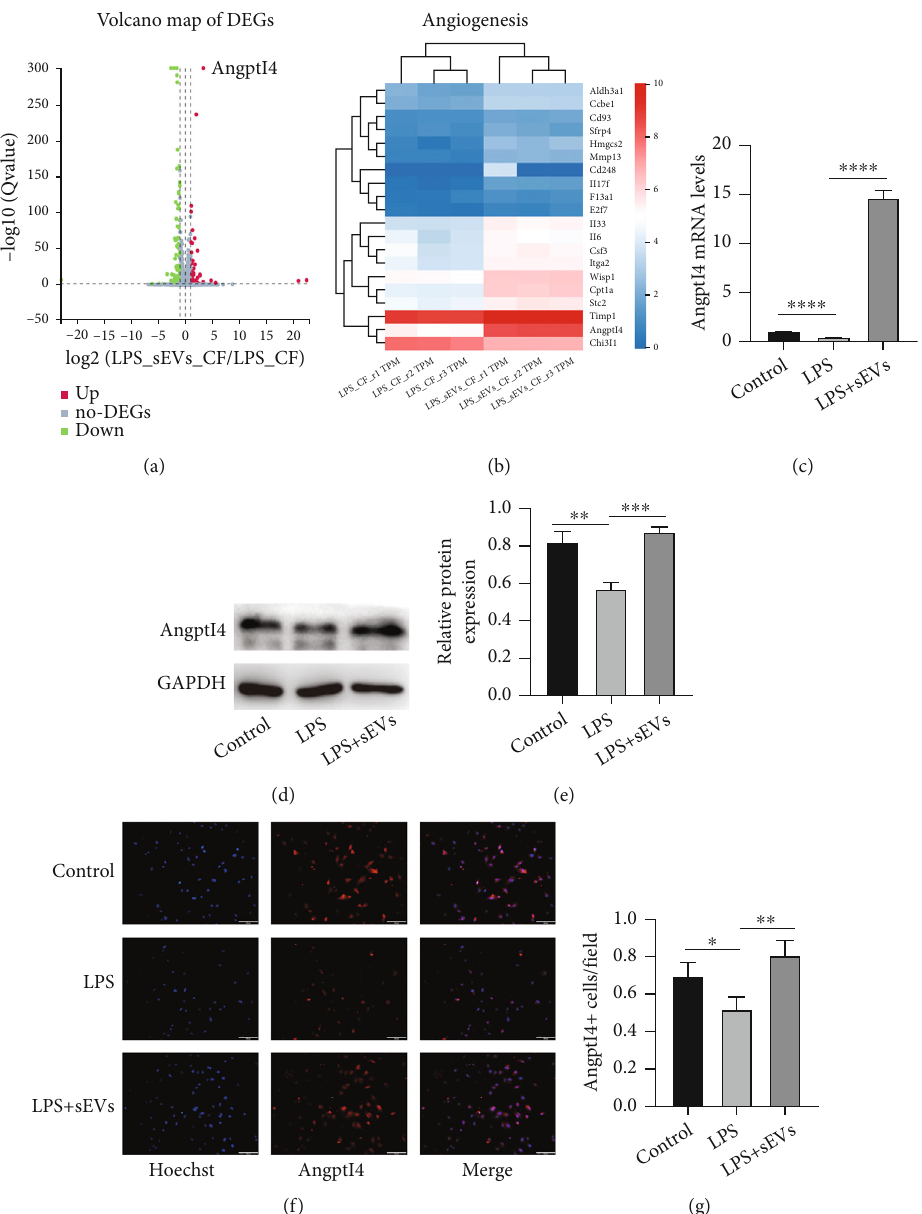
Figure 3: Angptl4 was increased in CFs treated with sEVs. Primary CFs were treated with LPS (100ng/mL) and LPS+sEVs (200 μ g/mL) for 24 h. mRNA expression of these two groups was compared via RNA-seq analysis. (a) Volcano map of DEGs. (b) Relative fold change of the top 20 angiogenesis-related genes for enrichment analysis. (c) Angptl4 mRNA expression was viewed by qRT-PCR. (d, e) Protein expression of Angptl4 was detected by western blotting. (f, g) Immuno fl uorescence was used to observe Angptl4 expression. Scale bar: 100 μ m. ∗ P < 0 : 05 , ∗∗ P < 0 : 01 , ∗∗∗ P < 0 : 001 , and ∗∗∗∗ P < 0 : 0001